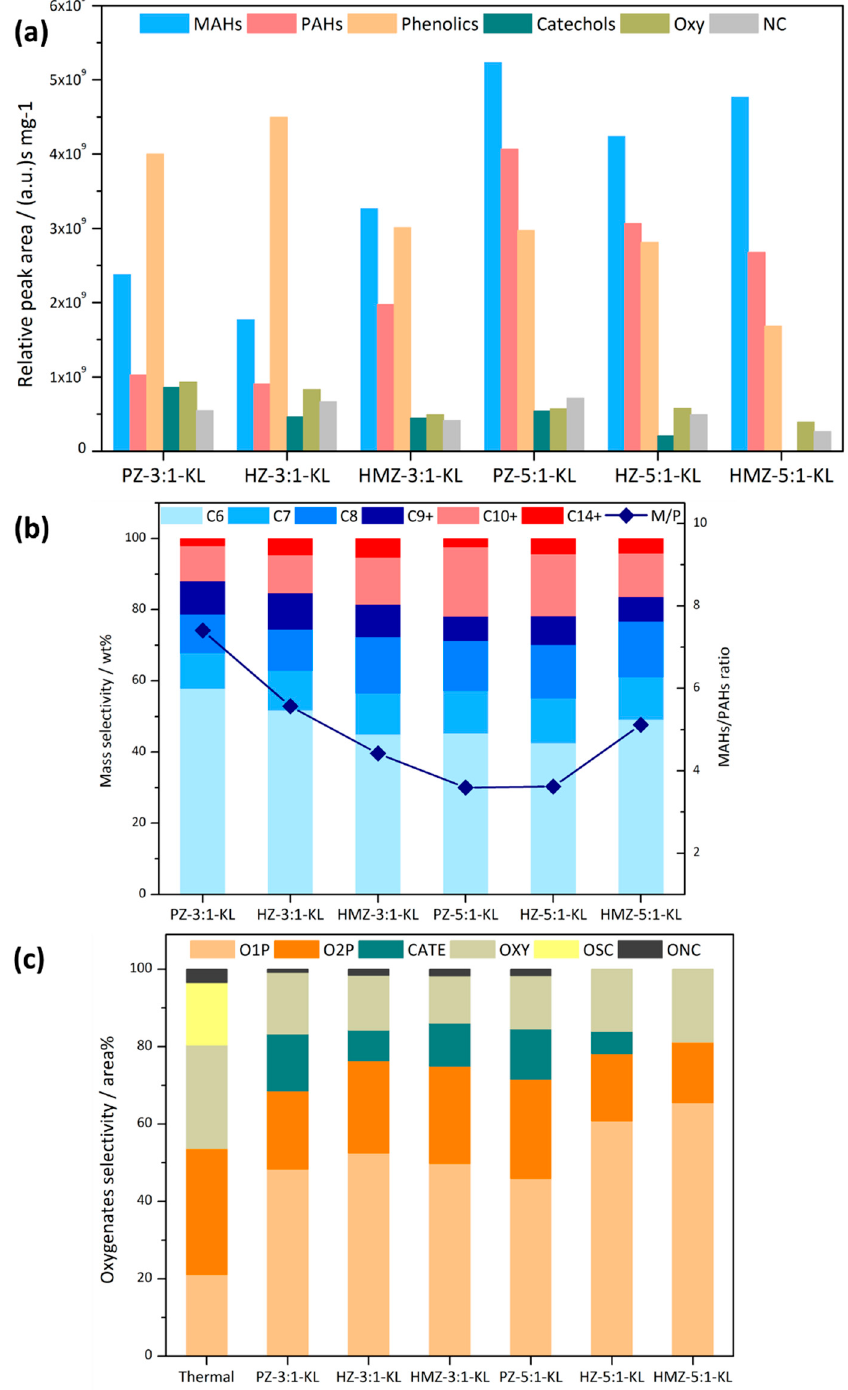
Figure 4. Product distribution of KL catalytic fast pyrolysis (CFP). ( a ) Overall distribution based on GC–MS peak area; ( b ) mass distribution of aromatics; ( c ) relative selectivity of oxygenated products.